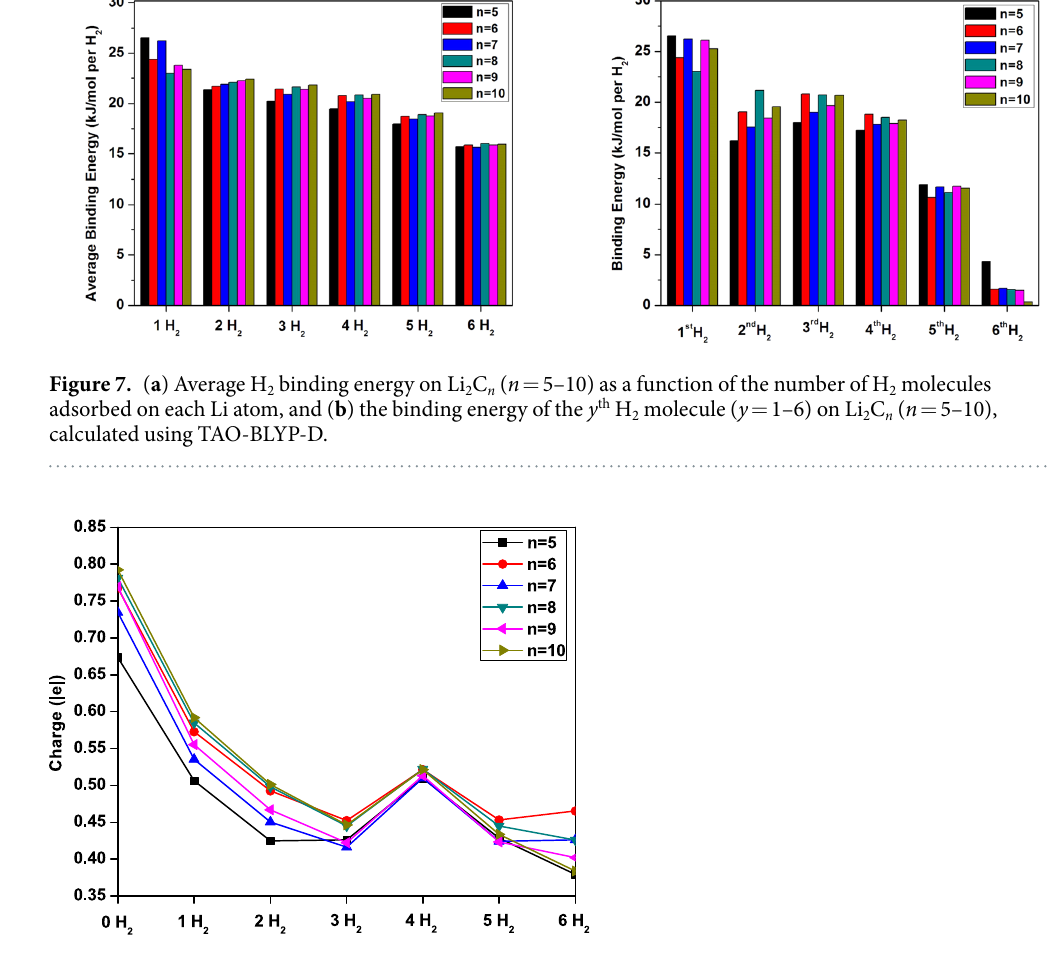
Figure 8. CHELPG atomic charge on each Li atom for Li 2 C n ( n = 5–10) with x H 2 molecules ( x = 0–6) adsorbed on each Li atom, calculated using